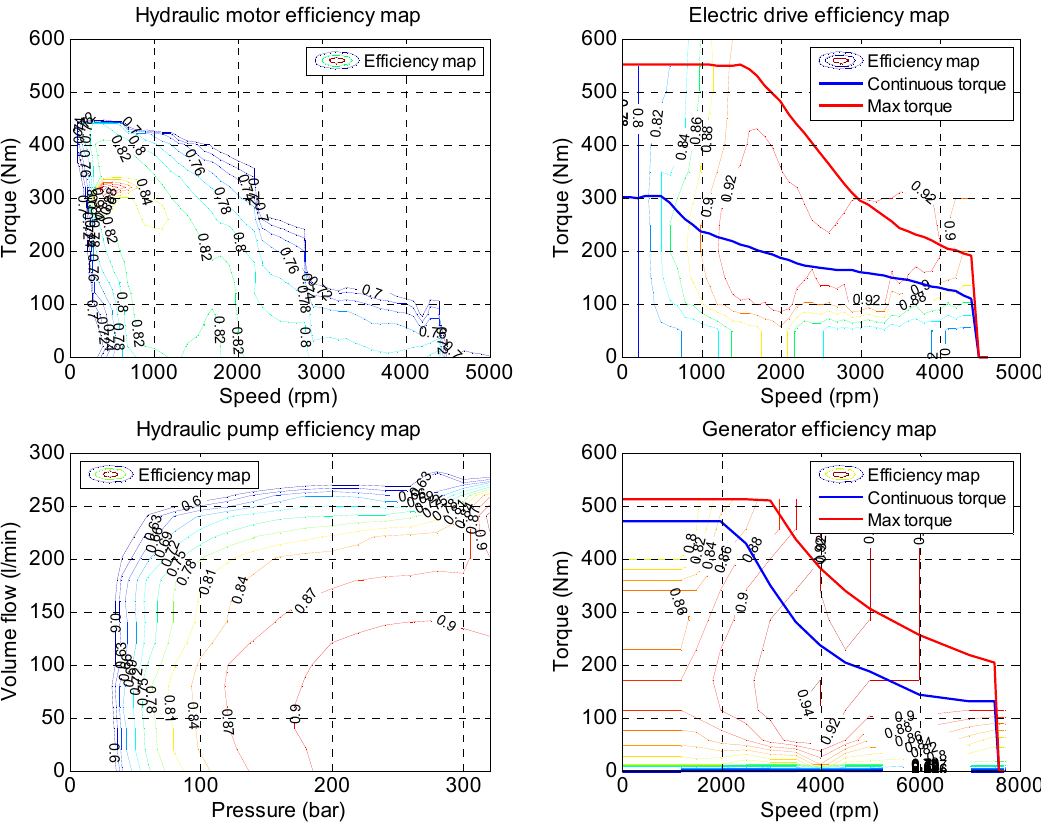
Figure 4. Comparison of the efficiency of a hydraulic pump to an electric generator and a hydraulic motor to an electric drive.